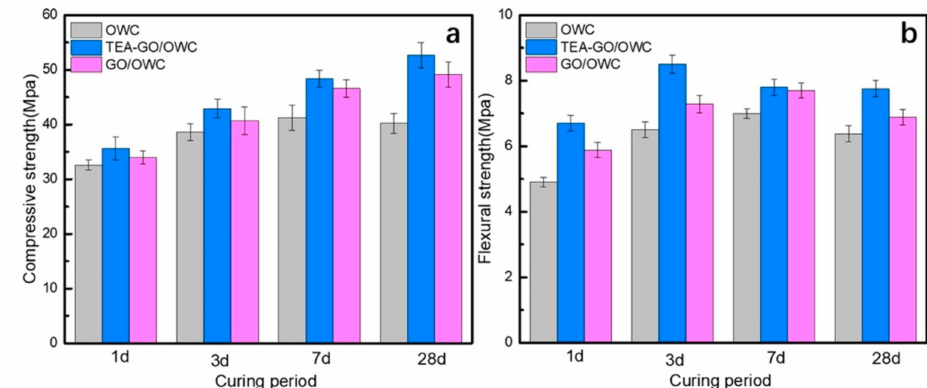
Figure 25. Response of the ( a ) compressive and ( b ) flexural strength of OWC composites containing GO and TEA-GO. Reprinted with permission from [159]. Copyright © 2019, Elsevier B.V.